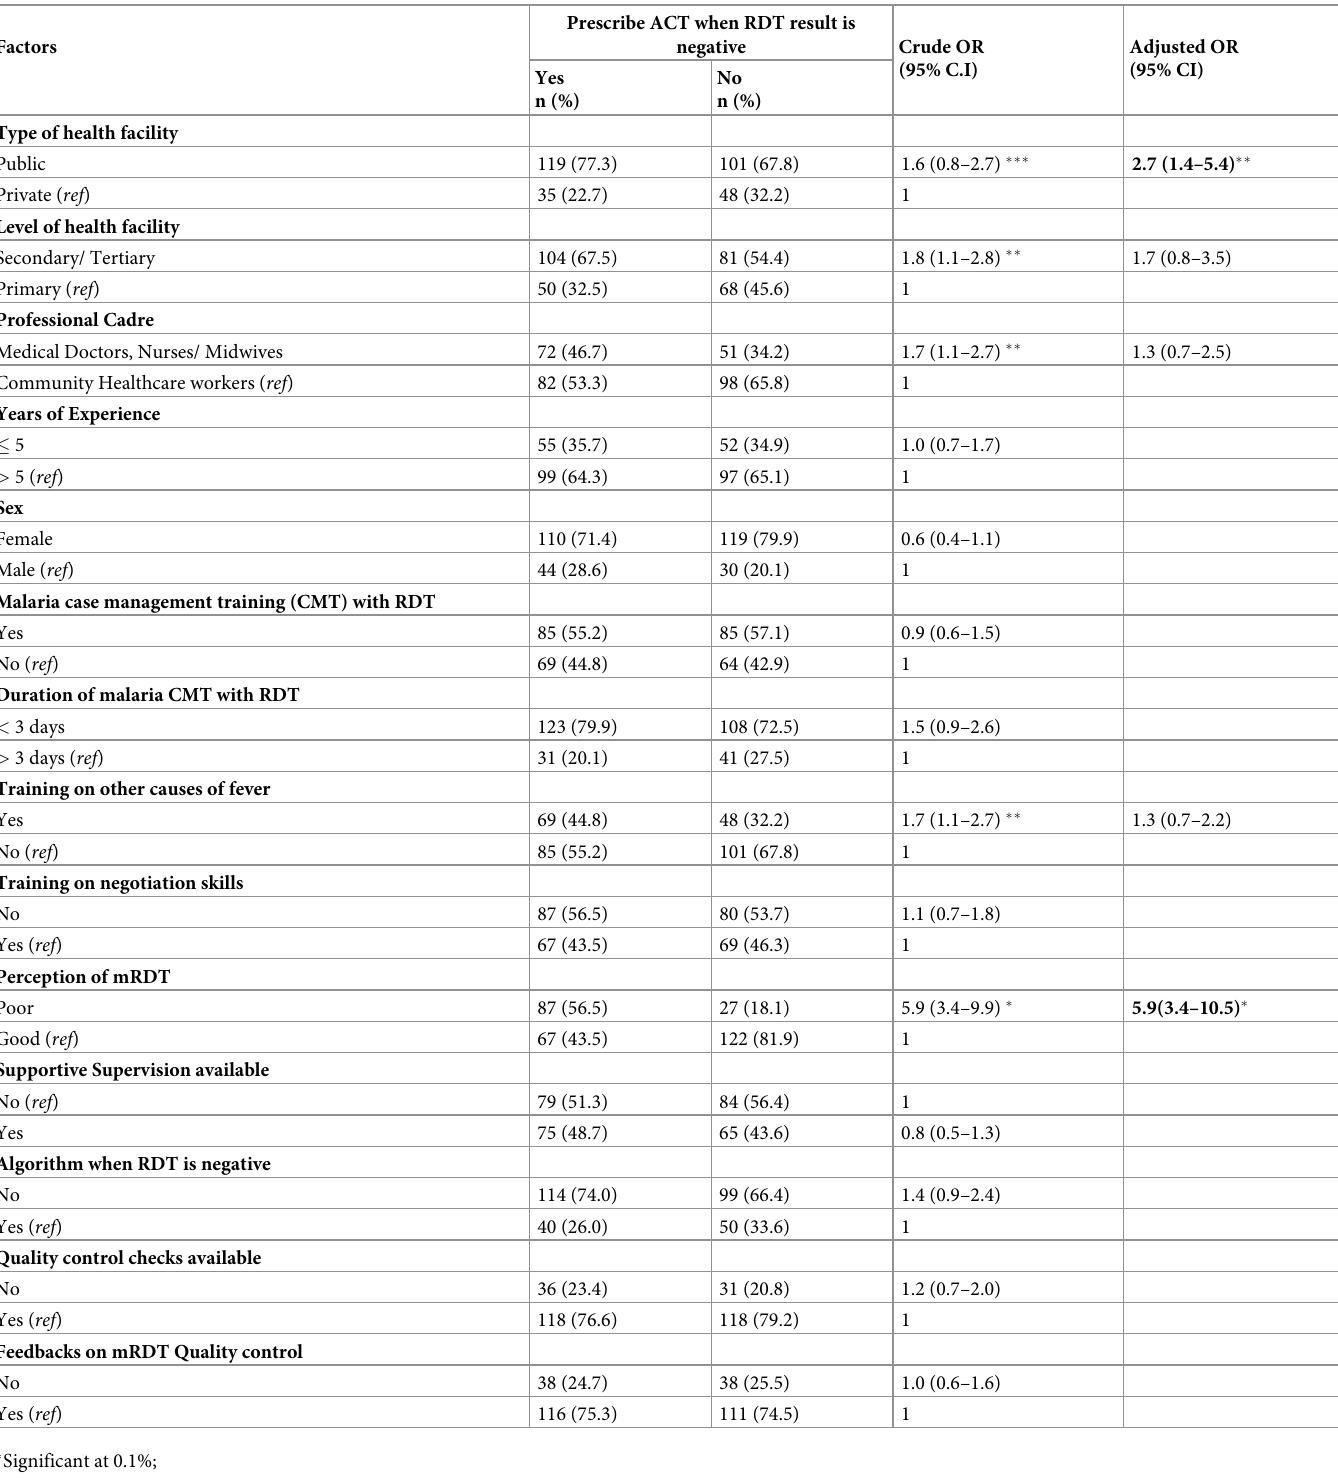
Table 3. Factors influencing ACT prescription for patients with negative mRDT results, Ebonyi